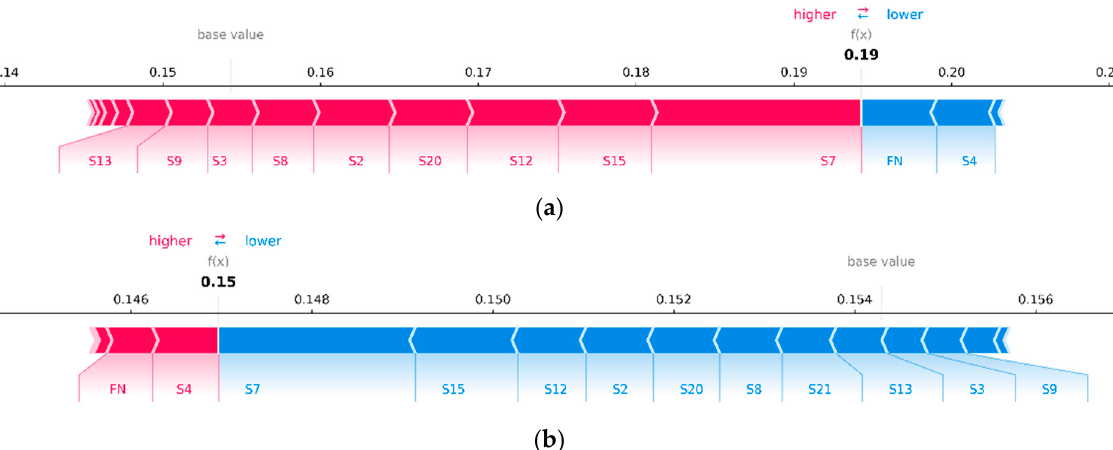
Figure 14. Contributions of features to the probability of engine failure, averaged over all time win- dows, for the failure of engines #81 ( a ) and #99 ( b ). windows, for the failure of engines #81 ( a ) and #99 ( b